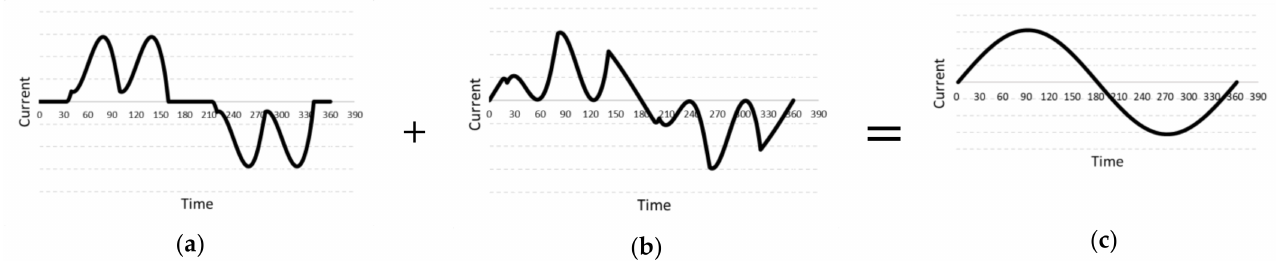
Figure 20. Current waveforms in phase a of the HTR. ( a ) Input current in rectifier 1. ( b ) Input current in rectifier 2. ( c ) Input current (sinusoidal) in the